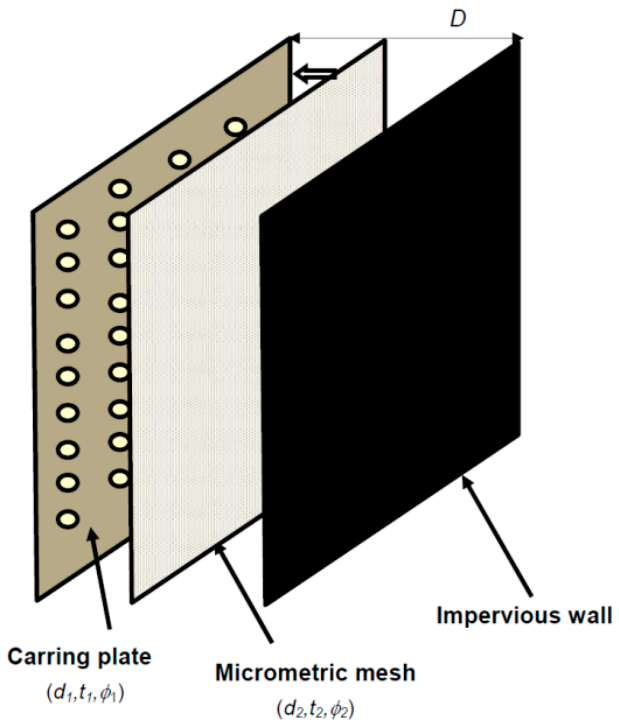
Figure 17. Sketch of the MIU design. Two single MPPs, the carrying plate and the micrometric mesh, are used to form the MIU. The horizontal arrow above the micrometric mesh means that it is moved to bond the carrying plate.